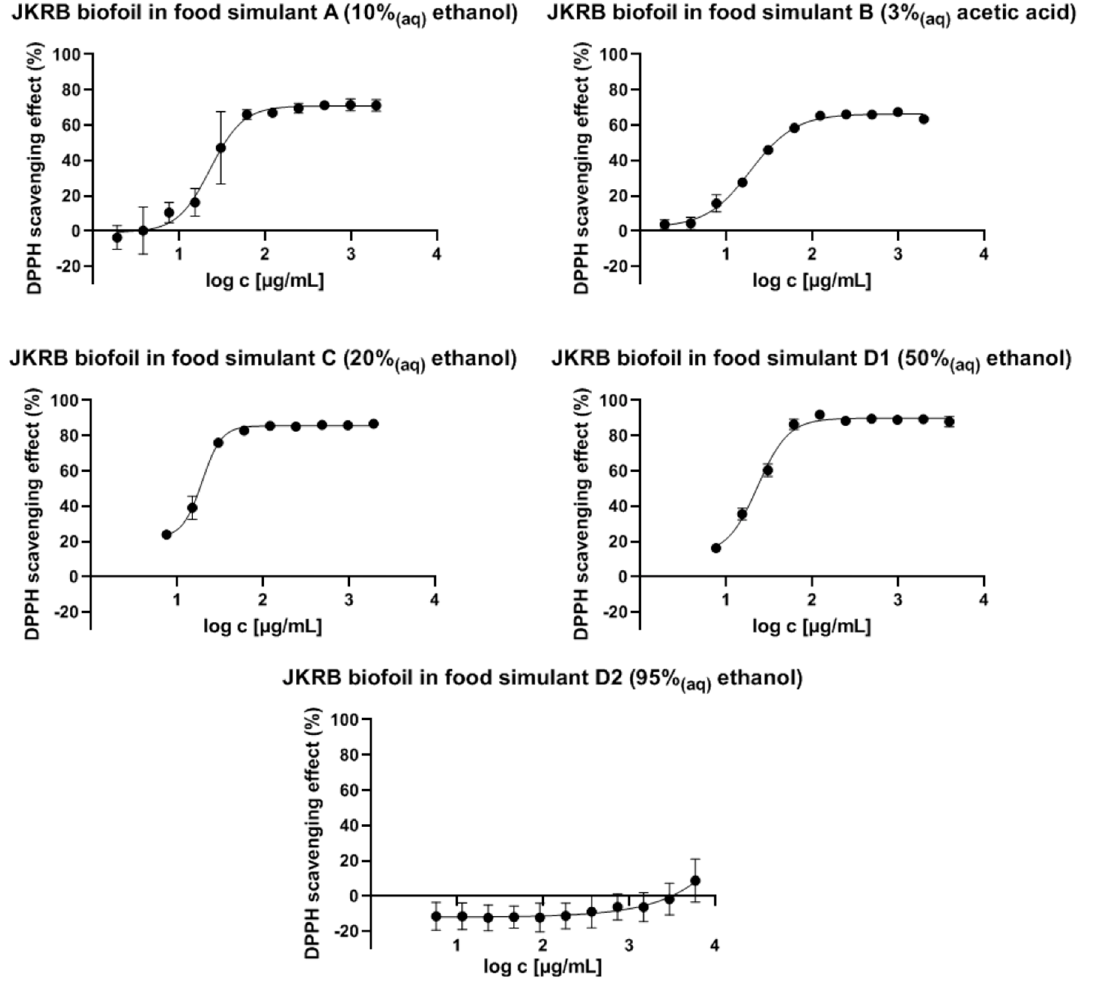
Figure 4. Logarithmic curves of the DPPH radical scavenging effect (%) relative to the “concentration” of JKRB biofoil in the liquid food simulants (graphs plotted using GraphPad Prism 9; Sigmoidal, 4PL fit). Table 1. Antioxidant activity of the food simulants, selected according to the European Commis ‐ sion’s document No 10/2011 [36], upon 1 h of contact with the formulated JKRB biofoil, and migra ‐ tion of the selected marker of the antioxidant activity, (–) ‐ epicatechin, from the JKRB biofoil into food simulants. The food simulants in contact with the chitosan (blank) biofoil did not show anti ‐ oxidant activity, except for food simulant E (not measured). Food Simulant